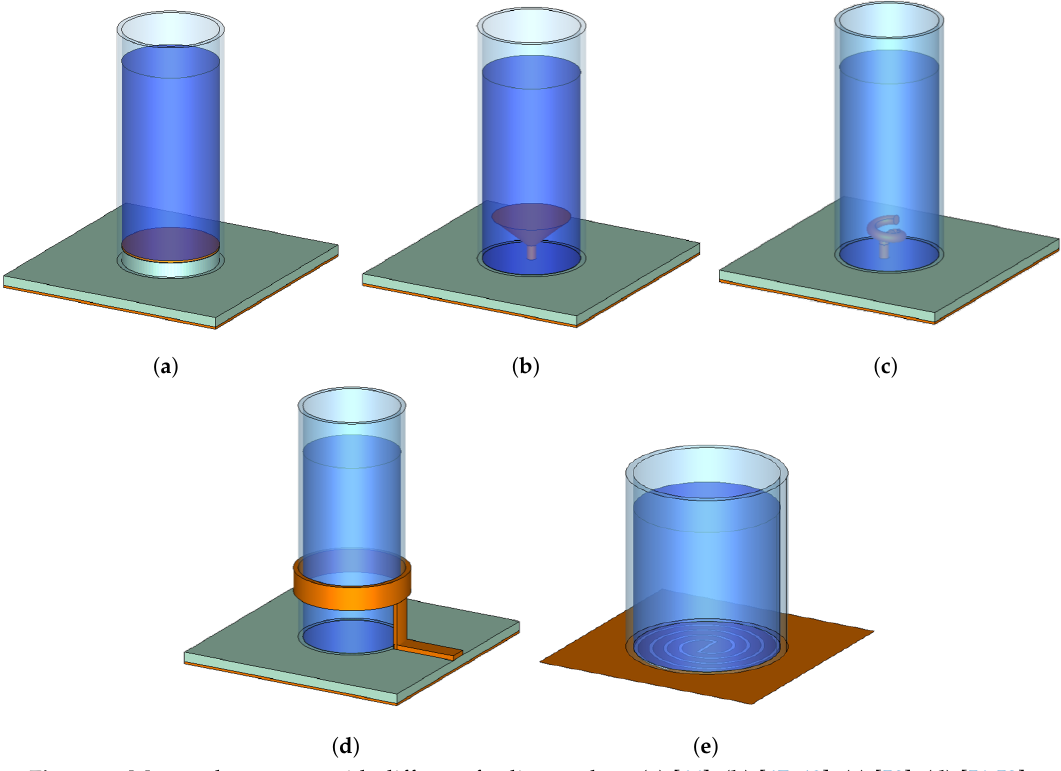
Figure 3. Monopole antenna with different feeding probes. ( a ) [46], ( b ) [47–49], ( c ) [50], ( d ) [51,52], ( e )